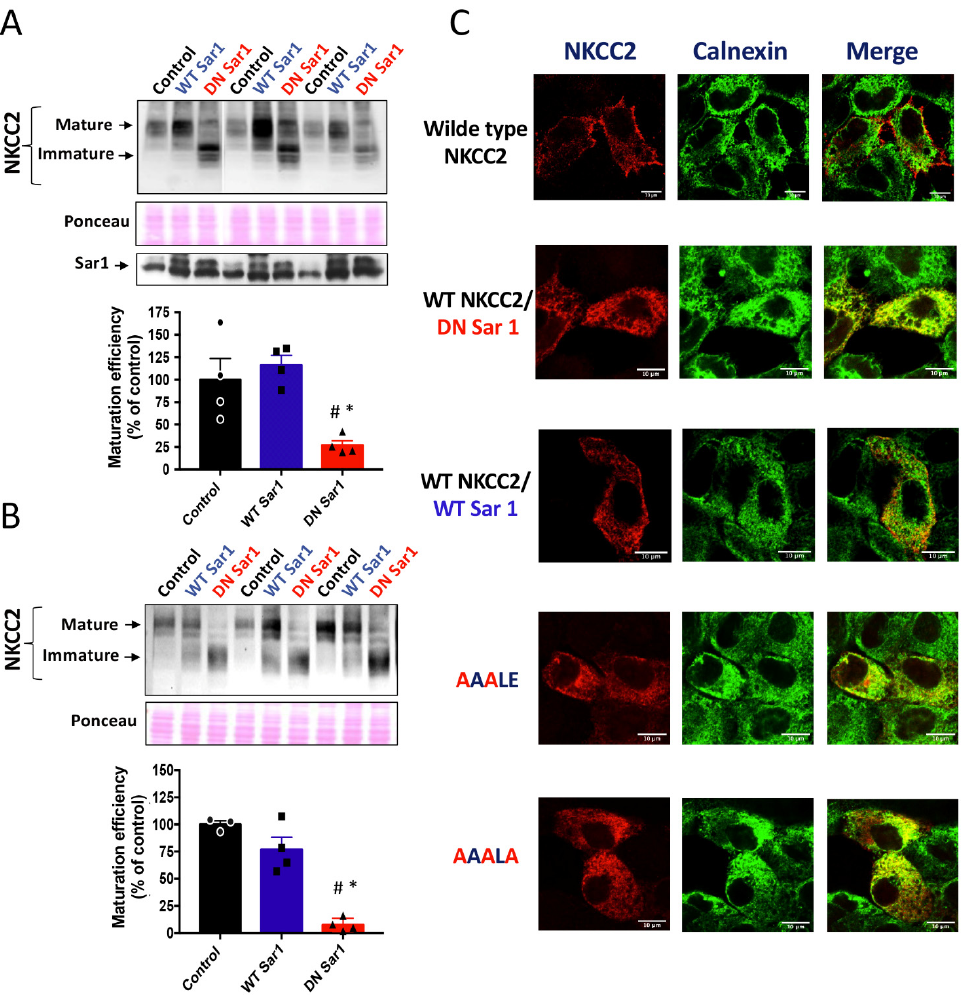
Figure 6. Loss of functional Sar1 GTPase inhibits ER NKCC2 export. ( A , B ) representative im- munoblot showing the effect of overexpressing WT Sar1 or its dominant negative (DN Sar1) Sar1 H79G on NKCC2 processing. ( A ) HEK cells were transfected with NKCC2 alone or with WT Sar1 or DN Sar1. 48 h post-transfection, total cell extract from each sample was run on a parallel SDS gel and immunoblotted for total NKCC2 using Myc antibody. Middle panel, the same membrane stained with Ponceau S to illustrate the equal loading of protein extracts. Lower panel, Representa- tive immunoblot illustrating the expression of endogenous Sar1 (control) and transfected WT Sar1 and its dominant negative in HEK cells. Sar1 proteins were detected using anti-Sar1A antibodies. ( B ) Quantitative analysis of the maturation efficiency of NKCC2 in the presence or absence of WT Sar1 or DN Sar1 in HEK cells, estimated as the ratio of the mature vs. immature form of the cotransporter. Data are expressed as percentage of control ± S.E. NKCC2 alone n = 3. NKCC2 with WT Sar1, n = 4. NKCC2 with DN Sar1, n = 4. # p < 0.0001 versus NKCC2 alone. * p < 0.0005 versus WT Sar1. ( C ) Representative immunoblot illustrating the effect of DN Sar1 in OKP cells. Lower panel, Quantita- tive analysis of the maturation efficiency of NKCC2 with or without WT Sar1 or DN Sar1 in OKP cells. Each point represents mean ± S.E of four independent experiments. # p < 0.02 versus NKCC2 alone. * p < 0.007 versus WT Sar1. ( C ) Comparison between the effects of mutating the 1019 DAELE 1023 motif and DN Sar1 on NKCC2 subcellular distribution. HEK cells transfected with mutated Myc-NKCC2 proteins as indicated, or with WT NKCC2 alone in the presence or absence of WT Sar1 or DN Sar1, were stained with mouse anti-Myc (Texas Red; red) and rabbit anti-calnexin (FITC; green). The yellow color indicates overlap between the Myc tag of NKCC2 protein (red) and the ER marker (green), representing co-localization of the proteins. Bars, 10 µ